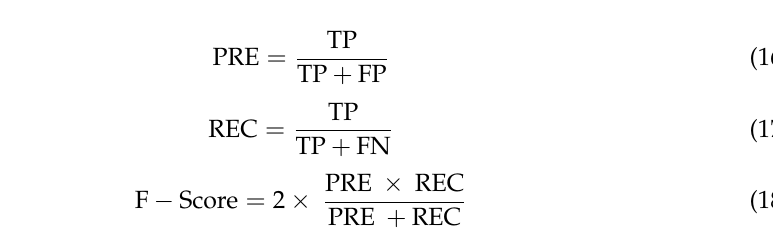
Table 2. Classification performance metrics.